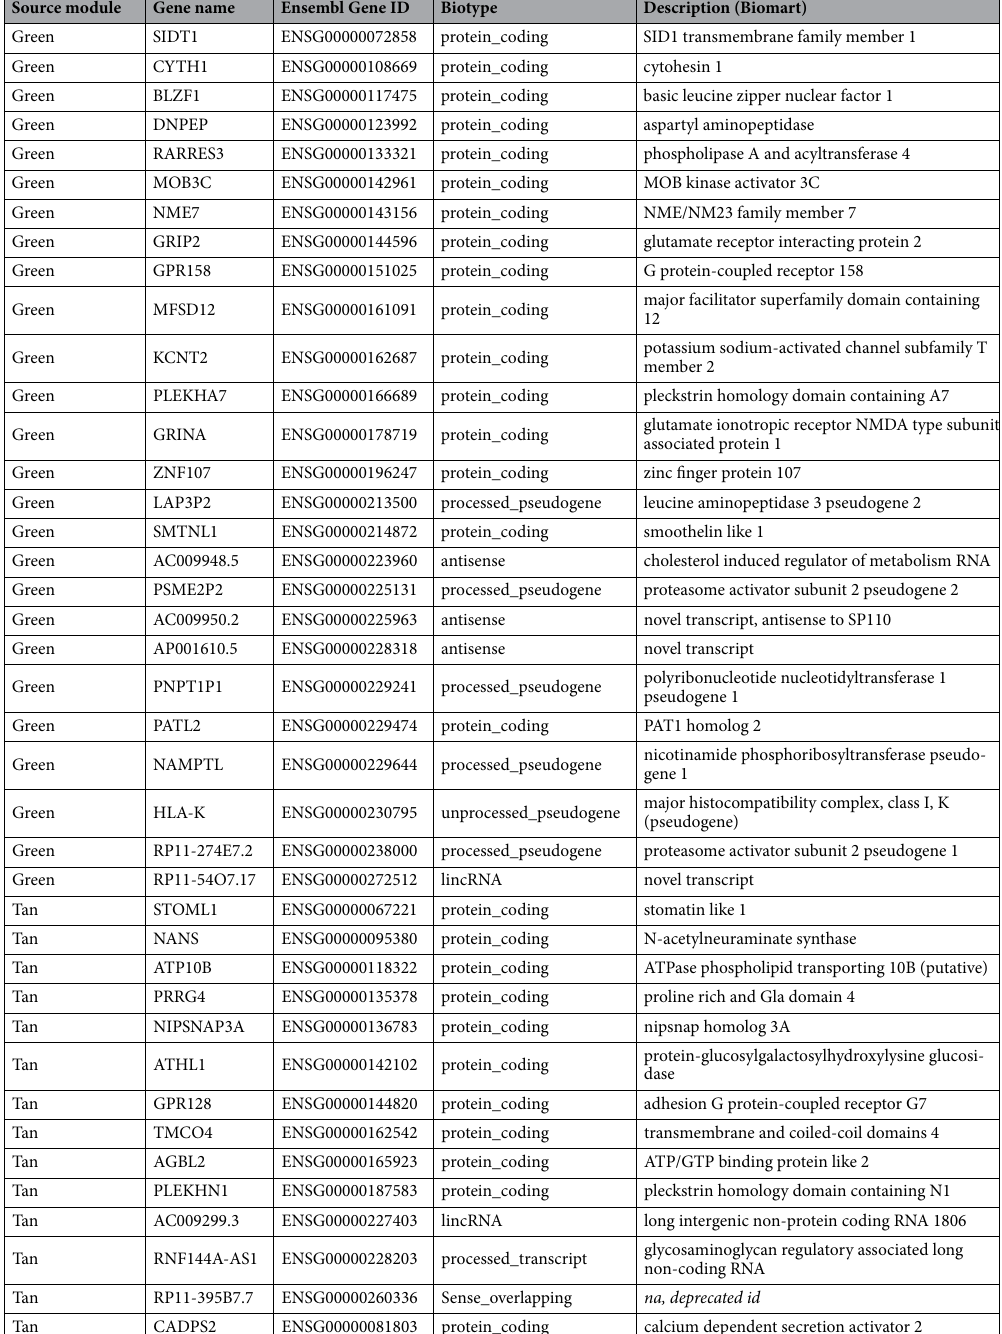
Table 2. Novel IFN sensitive genes. The 40 novel putative IFN sensitive genes (ISGs) annotated with the source module they were extracted from (Green or Tan modules), gene names, Ensembl gene IDs, biotype and description as retrieved from Ensembl